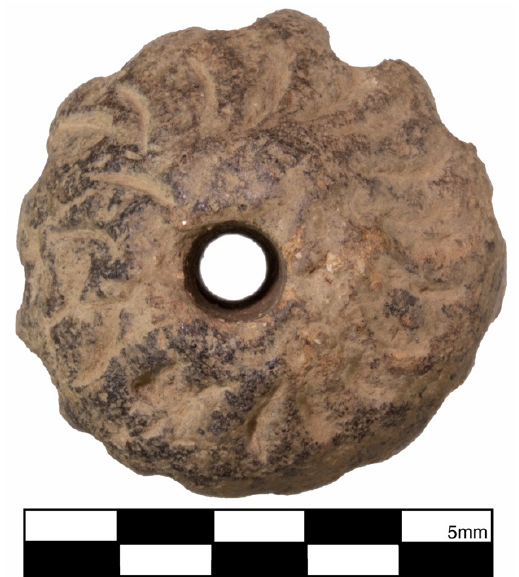
Figure 14. Archaic impasto Spindle whorl with possible fingernail impressions, 600–535 BCE (Image: Poggio Civitate Project).